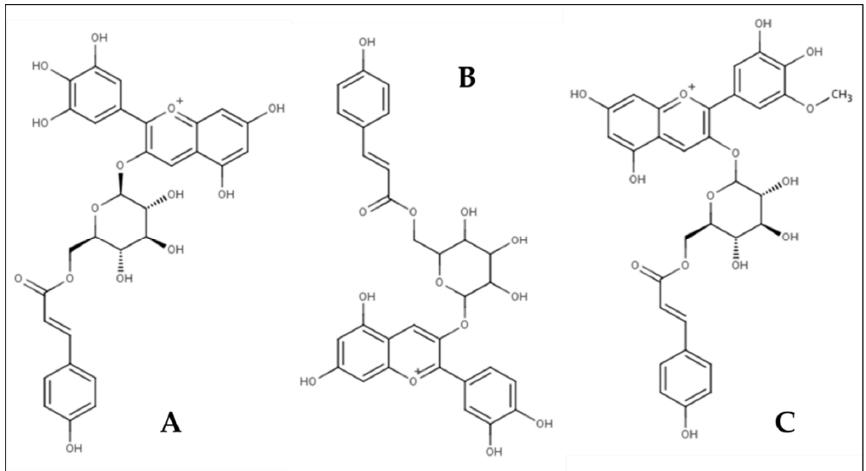
Figure 2. Chemical structure of delphinidin-3-(p-coumaroyl-glucoside) ( A ); cyanidin-3-(p-coumaroyl-glucoside) ( B ) and petunidin-3-(p-coumaroyl-glucoside ( C ). Figure adapted from (Neveu et al., 2012) [43].